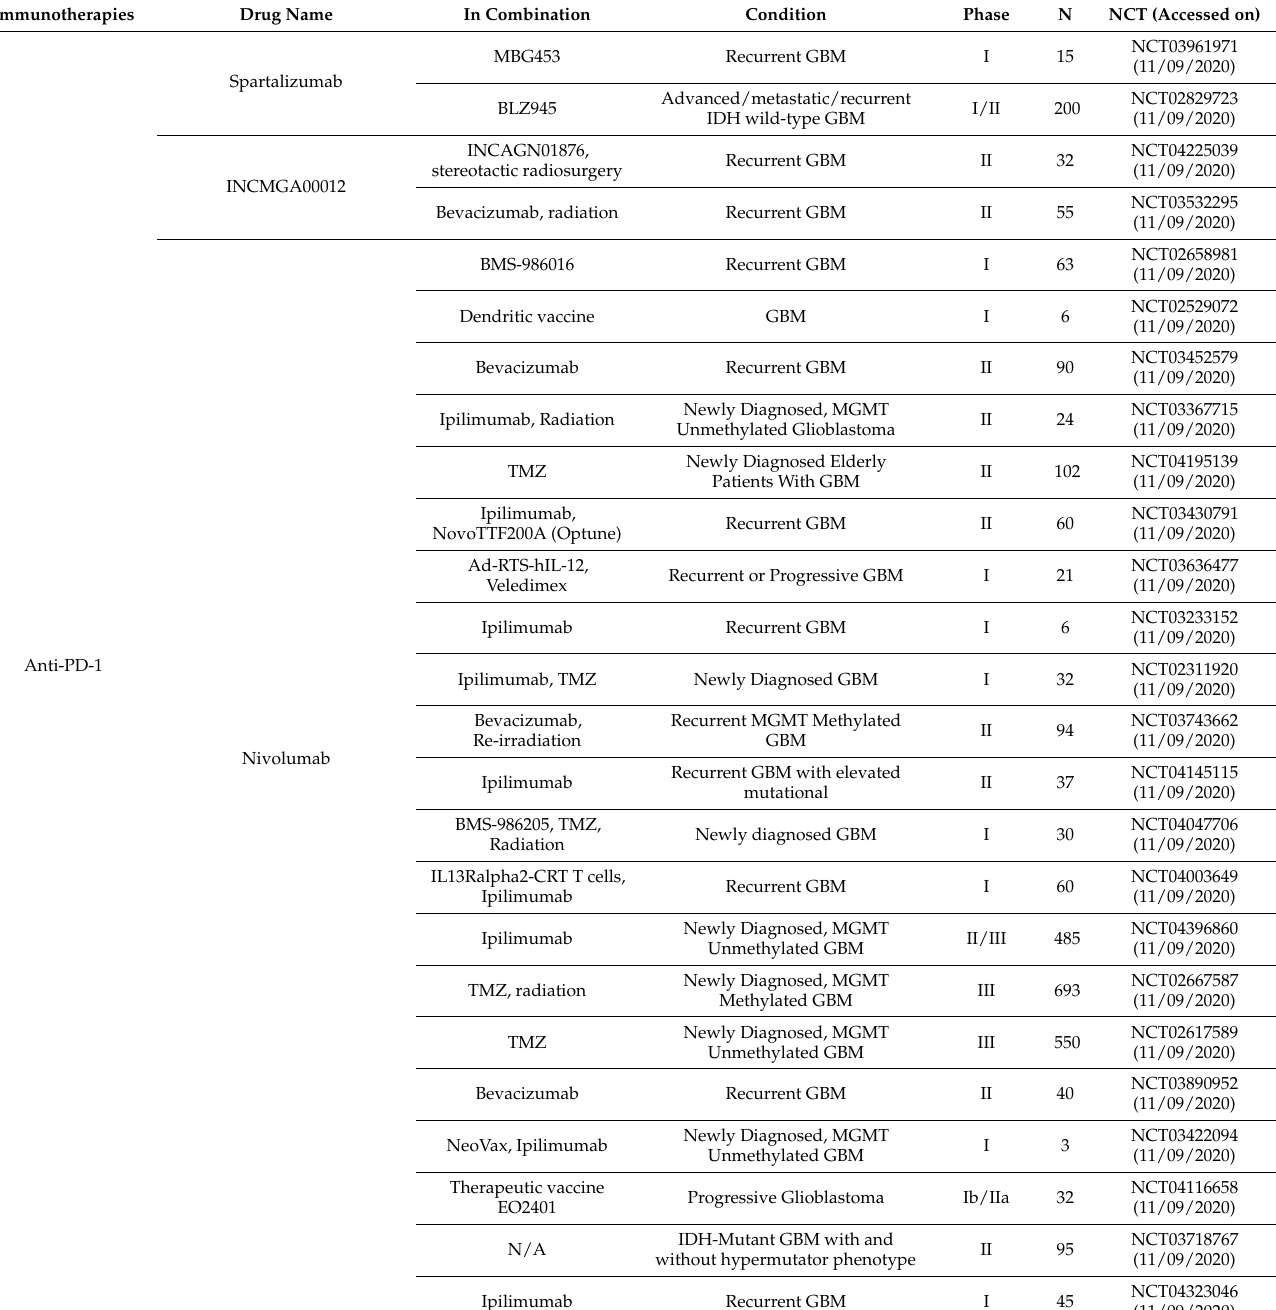
Table 3. Clinical status of immunotherapies in GBM within the last 5 years (since